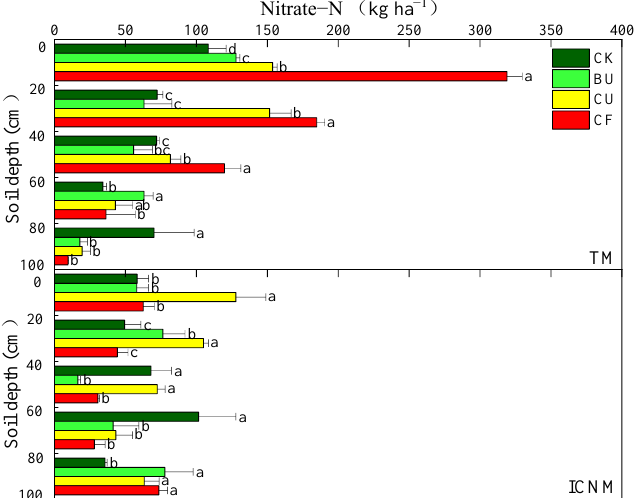
Figure 5. Distribution of nitrate − N in 0 − 100 cm of soil layer after harvest. Different lowercase letters indicate significant differences at p = 0.05.